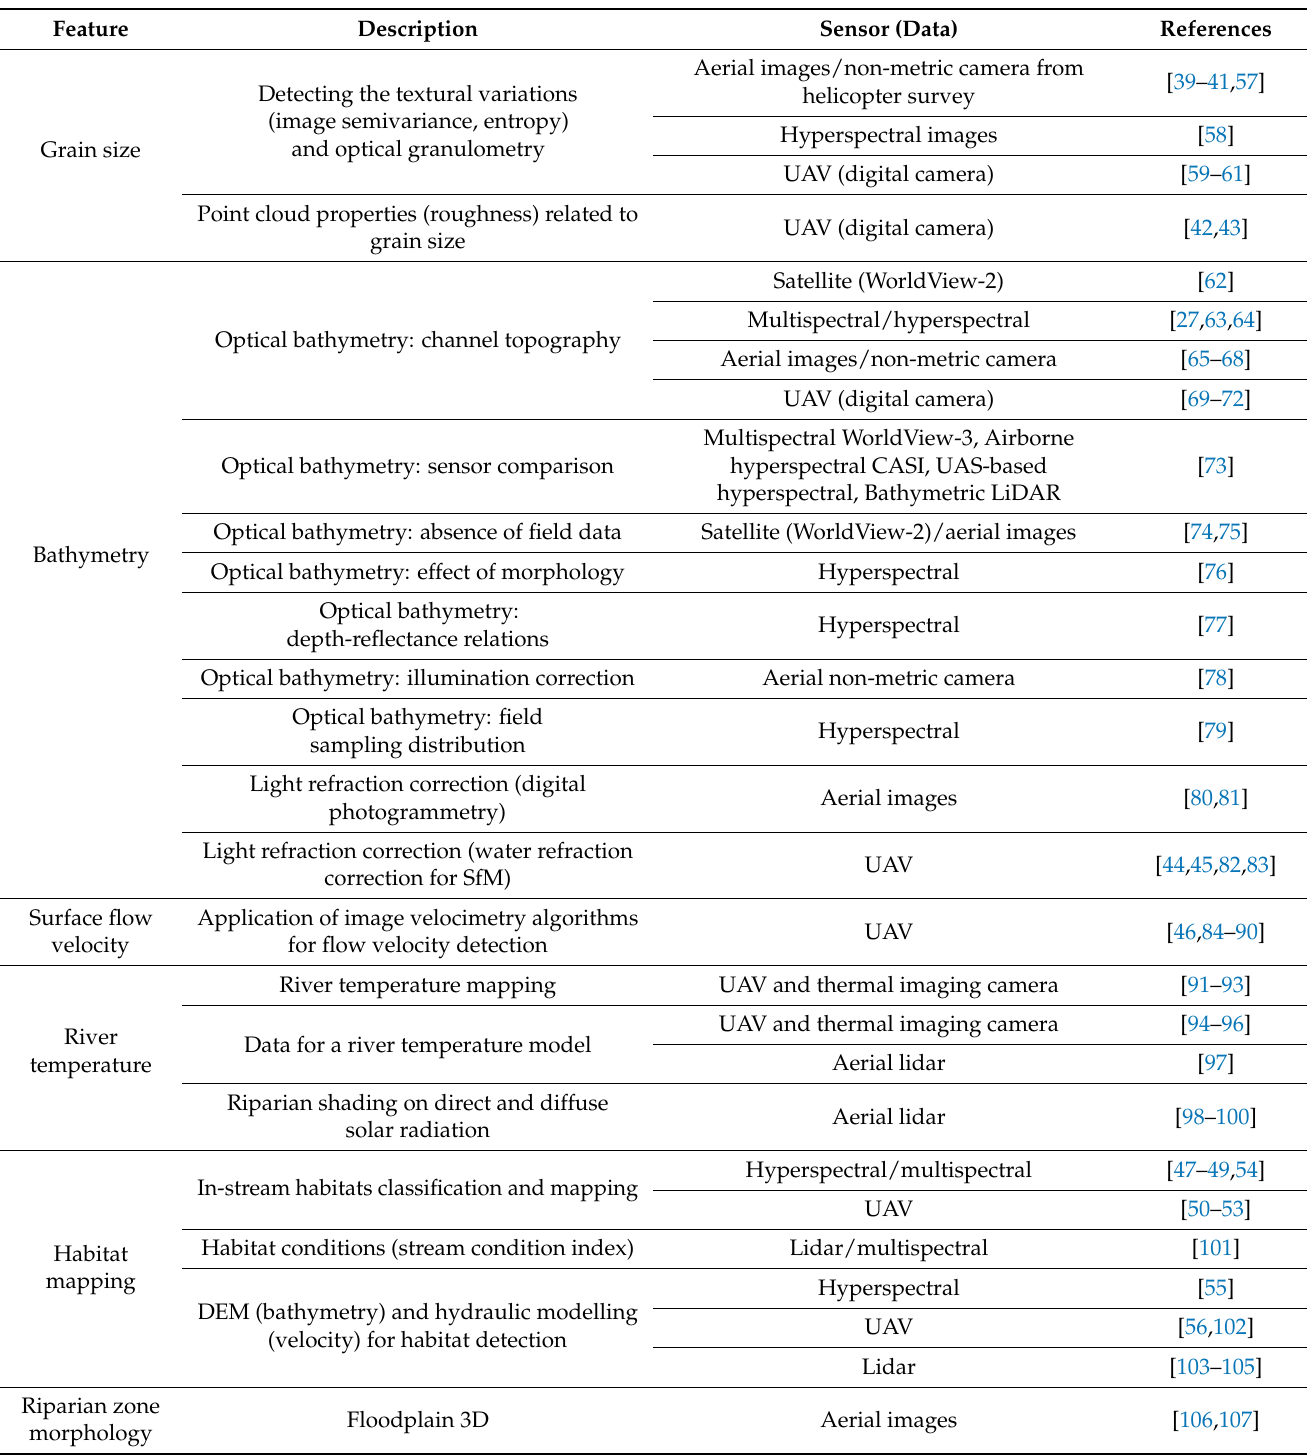
Table 1. Physical properties of river channel detected by remote sensing. Studies are sorted based on a short description of the methodologies and sensors